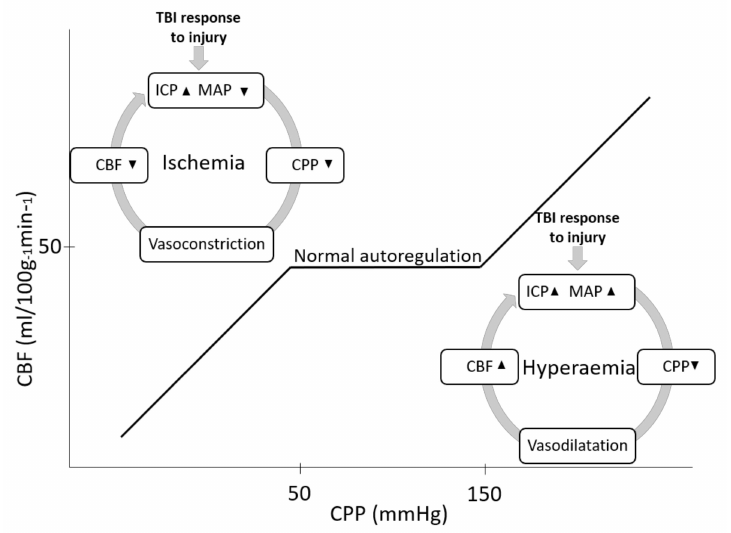
Figure 11. Cerebral autoregulation, where cerebral blood flow is maintained constant over a range of MAP/CPP. Out of the autoregulatory plateau, CBF becomes pressure-dependent and intracranial pressure dangerously rises (modified from [80,83,85,86]). Hypotension with disrupted cerebral autoregulation rapidly leads to cerebral ischemia, while hypertension above the autoregulatory threshold increases the risk of